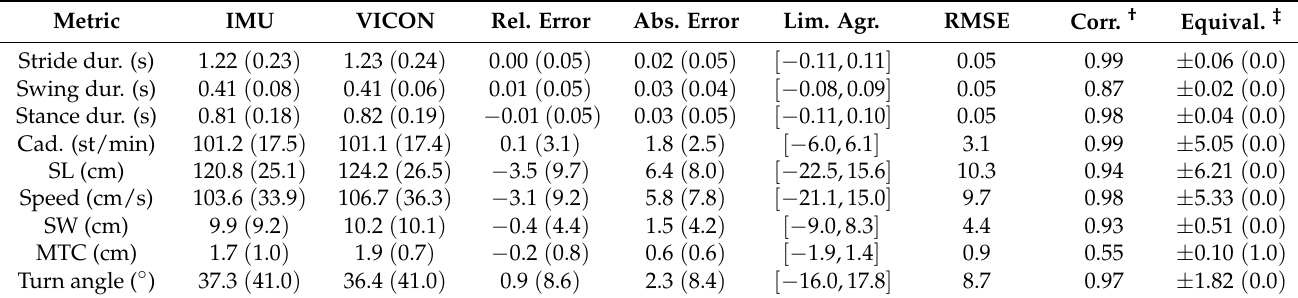
Table 4. Performance on the validation set, including turns ( n = 7015 strides). Shown are mean values (standard deviation), limits of agreement, RMSE, correlation and equivalence interval ( p -value). † All correlations were based on Spearman and have p < 0.01. ‡ Equivalence tests were based on Wilcoxon signed-rank test. Metric IMU VICON Rel. Error Abs. Error Lim. Agr. RMSE Corr. † Stride dur. (s) Stance dur.